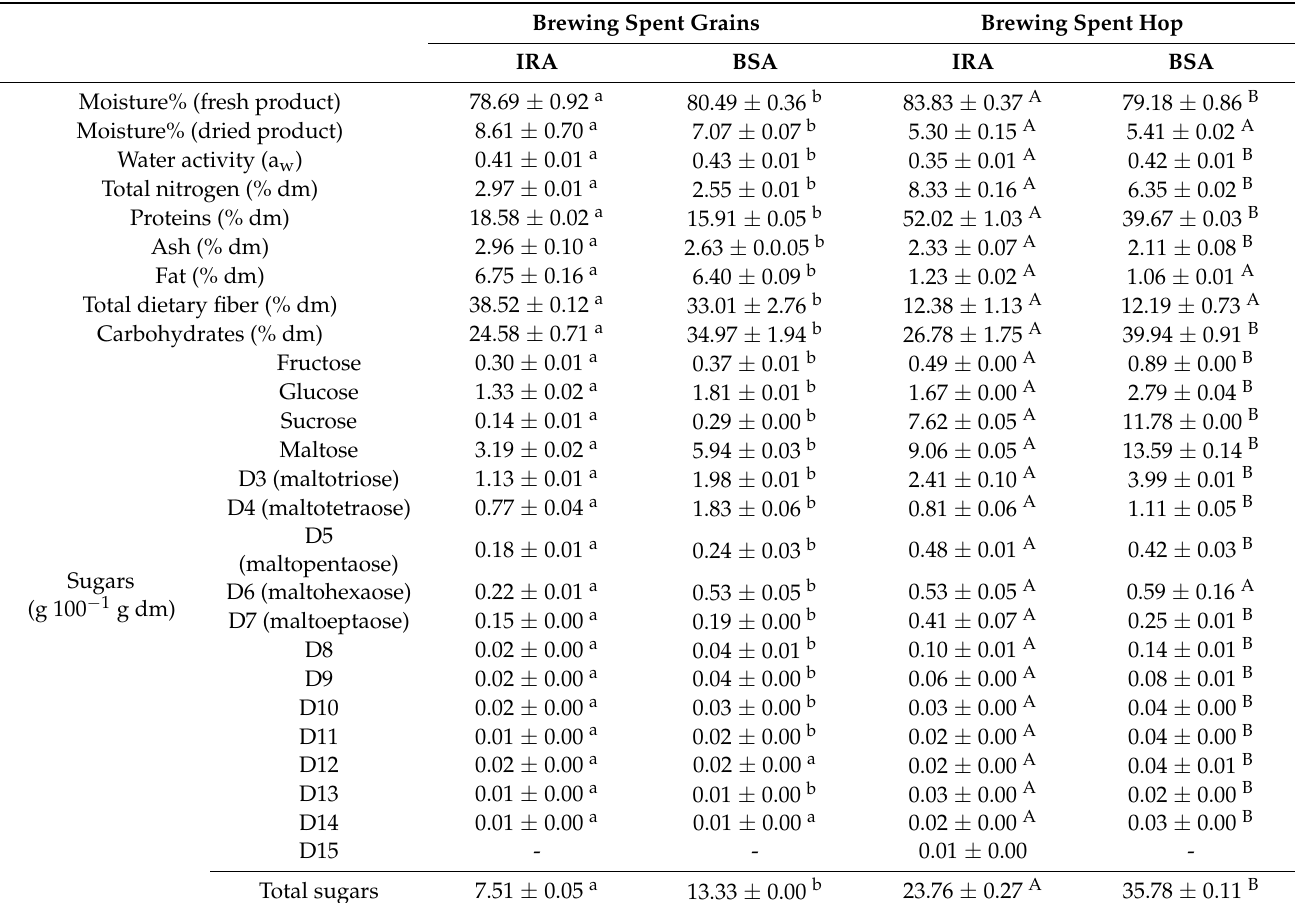
Table 2. Composition of spent grains (BSG) and spent hop (BSH) from the brewing of Imperial red ale (IRA) and Belgian strong ale (BSA) beers.